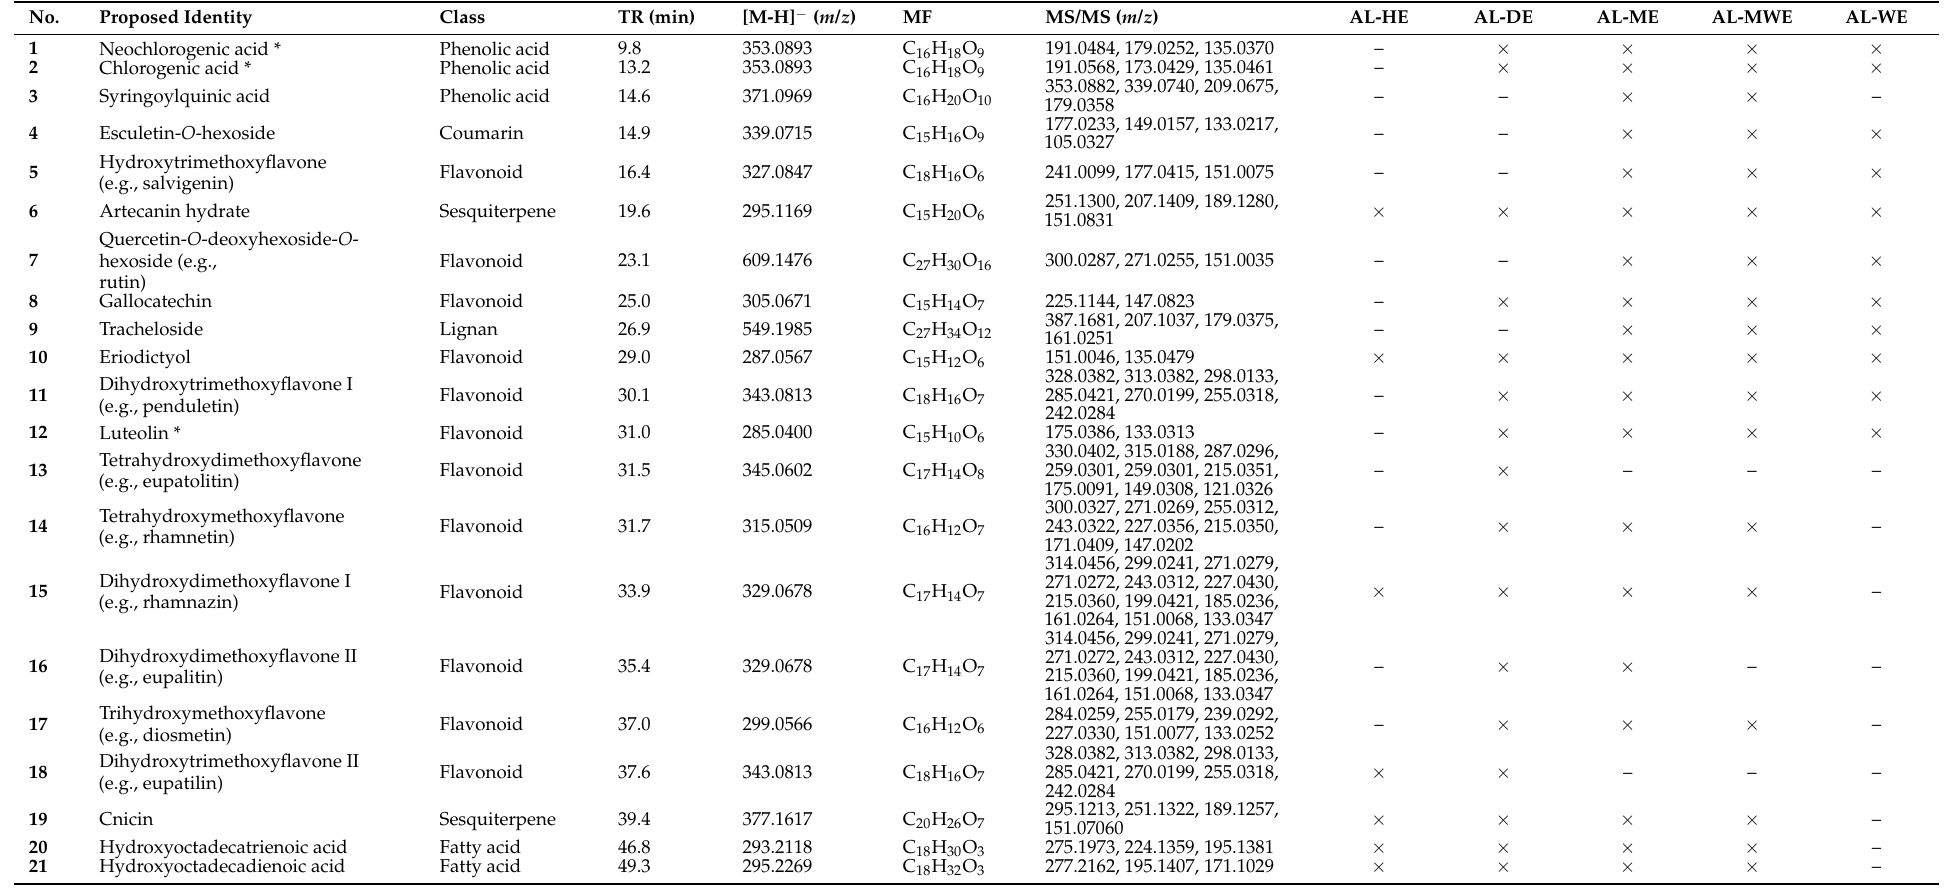
Table 2. LC-HRMS/MS-based metabolite profiling of the A. campestris subsp. lednicensis aerial part